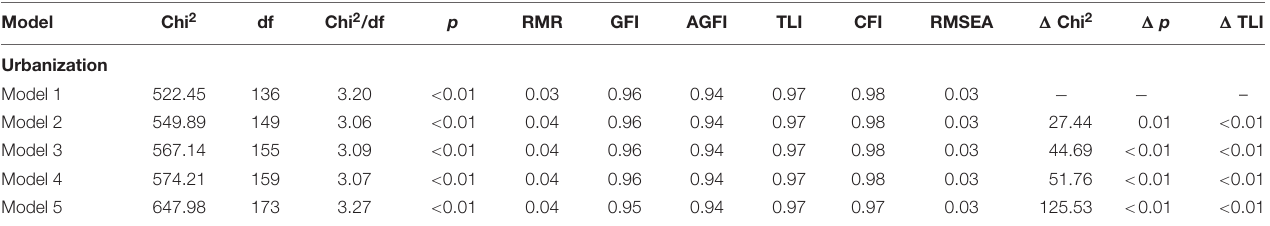
TABLE 4 | Nested Models of Multigroup SEM across urban and suburban. Model